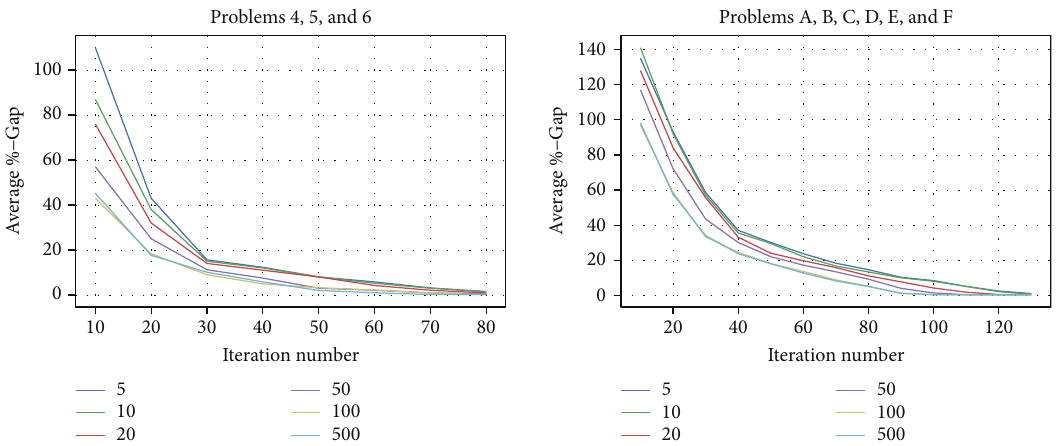
Figure 5: Convergence charts for instances of small and medium size